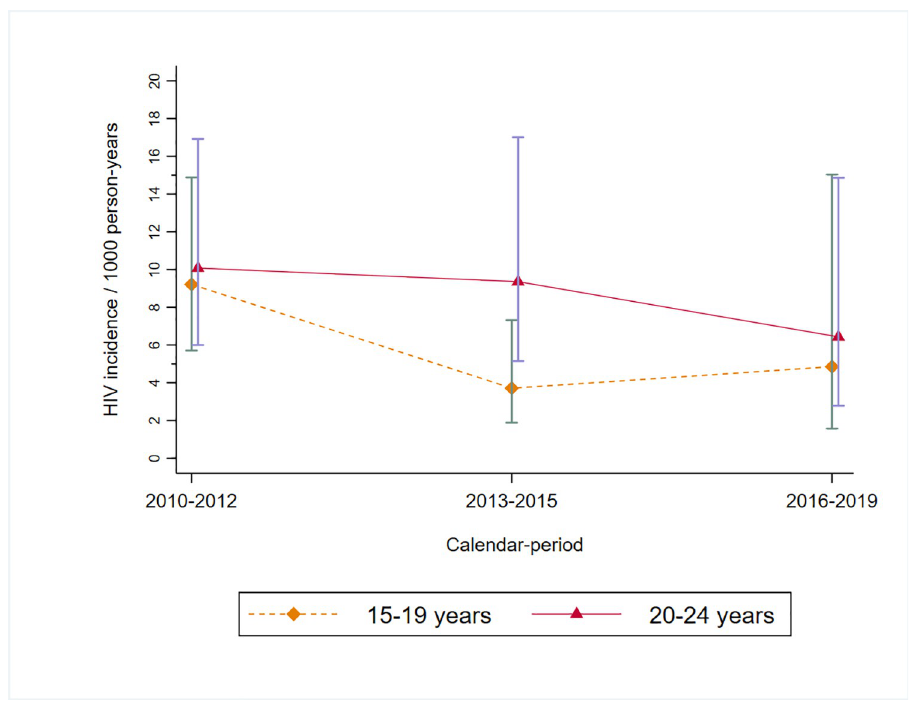
Fig 2. HIV incidence rates over time among AGYW with 95% CIs, in Gem, Kenya. AGYW, adolescent girls and young women; CI, confidence interval.